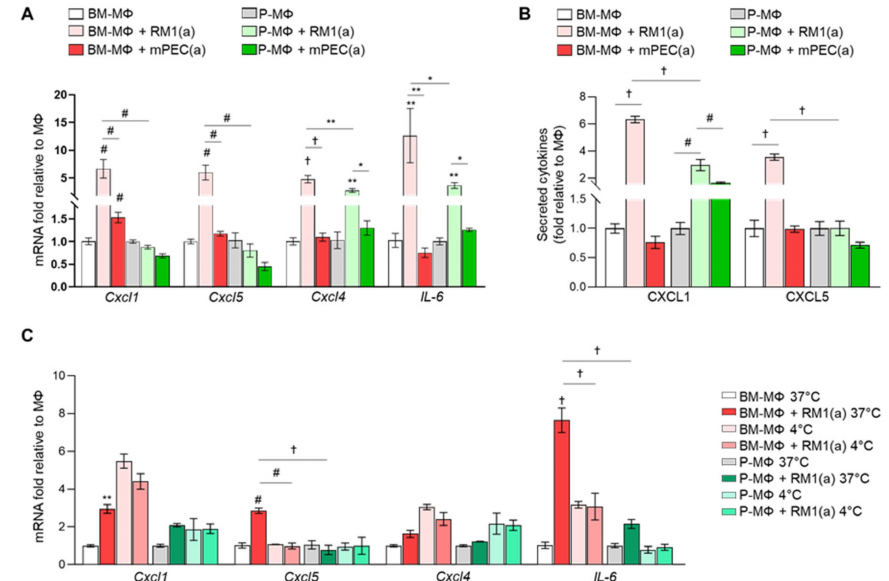
Figure 3. Di ff erential gene expression of bone marrow-derived and peritoneal macrophages after e ff erocytosis of apoptotic prostate cancer cells and normal prostate epithelial cells. ( A ) mRNAs isolated from BM-M Φ s and P-M Φ s alone or co-cultured with apoptotic prostate cancer cells RM1(a) or apoptotic prostate epithelial cells mPEC(a) for 18–20 h were analyzed by quantitative PCR (qPCR) for the specified genes. ( B ) Conditioned media from ( A ) were analyzed by ELISA for total CXCL1 and CXCL5 levels. ( C ) qPCR analysis of BM-M Φ s and P-M Φ s during e ff erocytosis permissive (37 ◦ C) or inhibitory (4 ◦